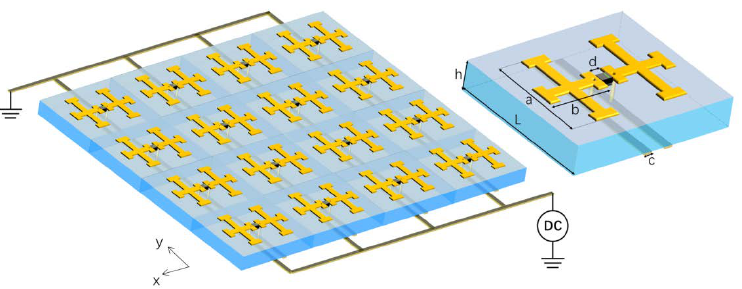
Figure 1. The schematic of the tunable EIT-like metamaterial; the insertion: the metamaterial unit cell.